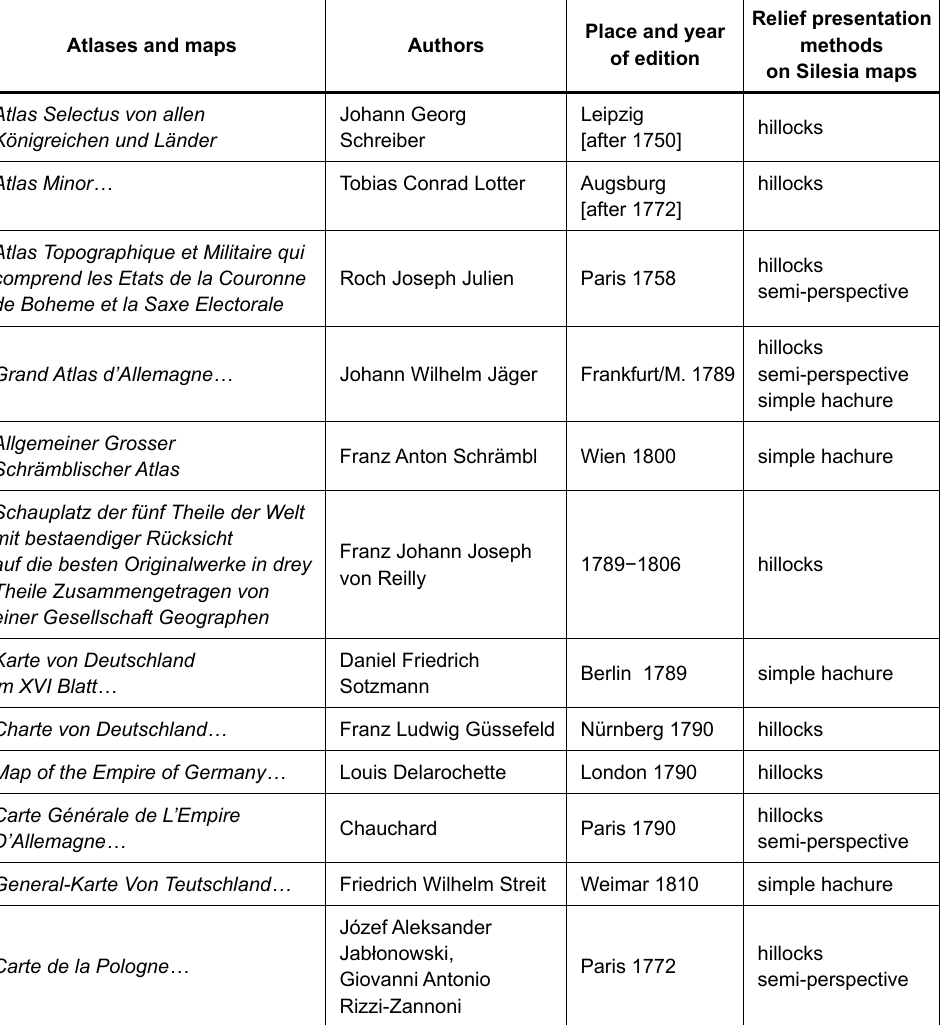
Table 1. Atlases and multi-sheet maps of the world, Germany and